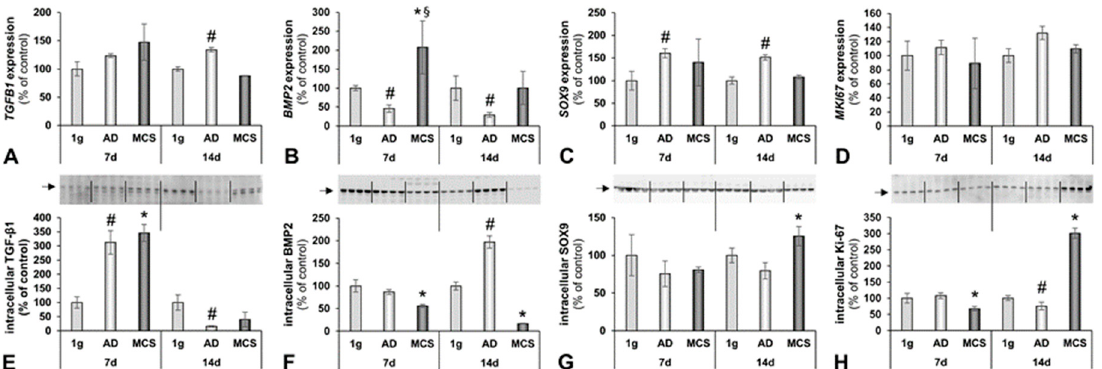
Figure 5. Bone-specific factors influenced by simulated microgravity. Gene expression of selected genes: ( A ) TGF- β 1 ( TGFB1 ); ( B ) BMP2 ( BMP2 ); ( C ) SOX9 ( SOX9 ); and ( D ) Ki-67 ( MKI67 ). Intracellular ECM protein levels: ( E ) TGF- β 1; ( F ) BMP2; ( G ) SOX9; and ( H ) Ki-67. All values are given as mean ± standard deviation. # p < 0.05 1 g vs. AD; * p < 0.05 1 g vs. MCS; § AD vs. MCS, p < 0.05, d, days.